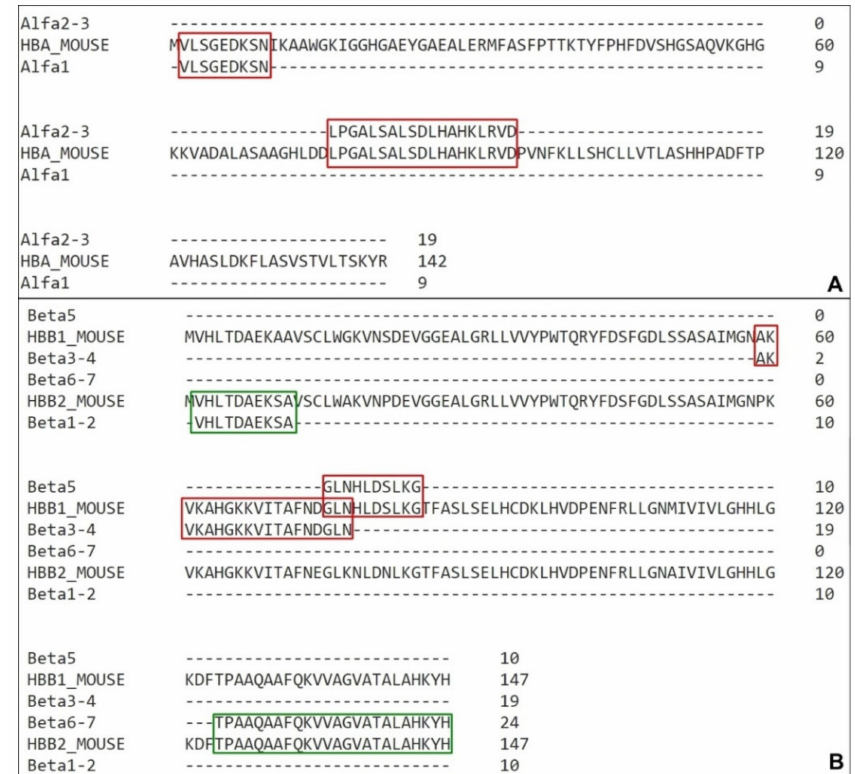
Figure 4. Coverage of Mus musculus hemoglobin sequences with high confidence active molecules. ( A ) Alignment of the highest-score fragments obtained through mass spectrometry with the mouse hemoglobin α chain. ( B ) Alignment of the highest score fragments obtained through mass spectrometry with the mouse hemoglobin β 1 and β 2 chain (HBB1 and HBB2, red and green respectively). Sequences compilation was performed to avoid residues repetitions. The residues coverage is highlighted in red and